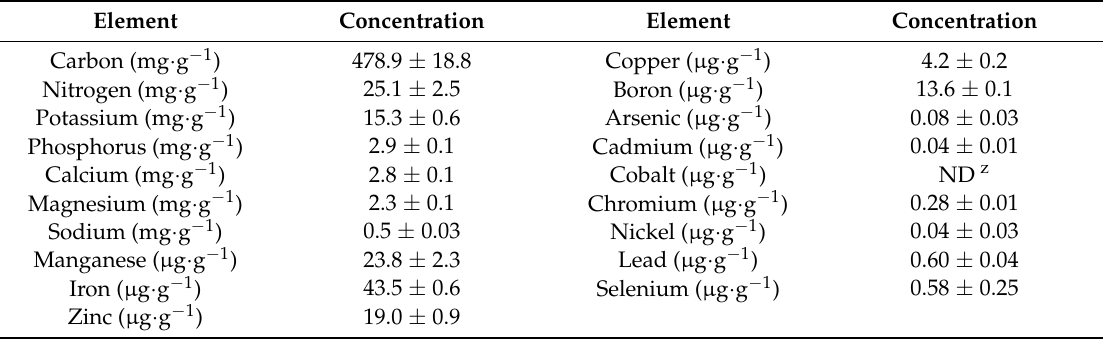
Table 4. Essential elements and metal concentrations in Cycas micronesica leaves. Data were presented as mean ± standard error for n =